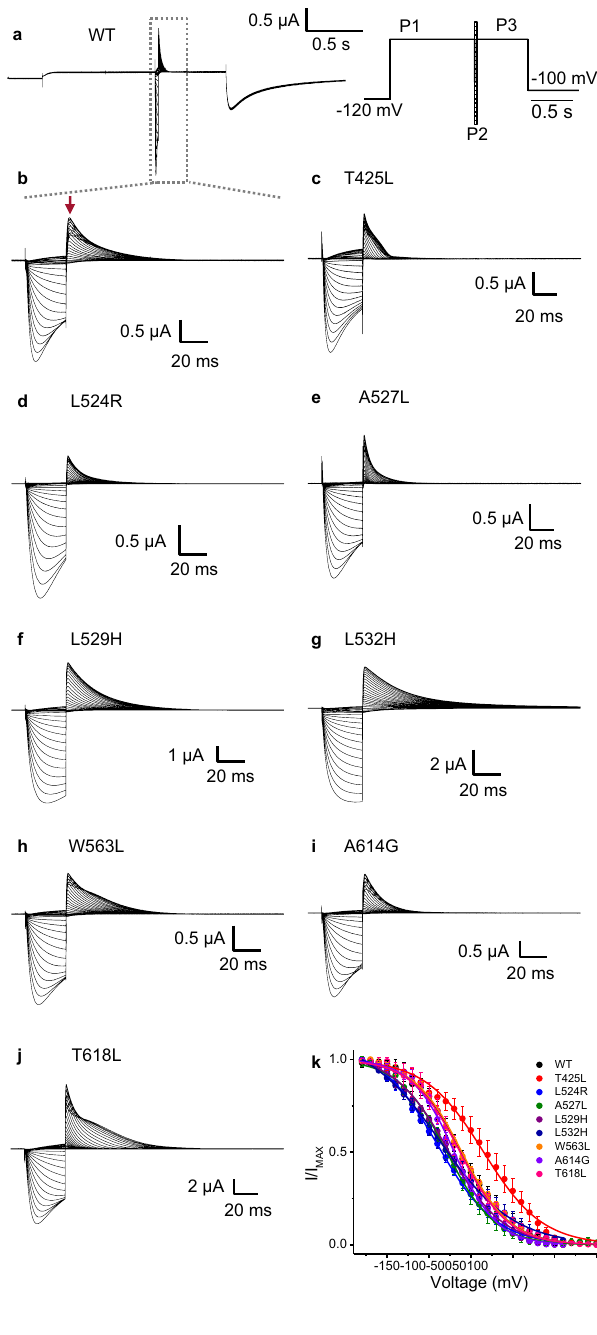
Fig. 4 | Voltage dependence of inactivation for mutations involved in the noncanonical path in hERG. a Currents elicited using a classical three-pulse vol- tageprotocolshowninsetina.Avoltagepulseto+20mV(P1)wasappliedfor1sto fully activate/inactivate the channel, followed by a voltage pulse (P2) applied to differentpotentialsfrom − 180to+60mVfor30ms.Thispulsewasusedtoremove inactivationwithoutallowingsuf fi cienttimeforsigni fi cantdeactivationtooccur.A fi nal pulse (P3) was then applied to +20mV for the reopening and allowed the channels to reenter into the inactivated state. For better appreciation of the cur- rentselicitedbypulses2and3,weexpandedthetimewindowofthecurrenttraces (dashed grey square in a ). b – j are, respectively, the representative expanded time window for WT, T425L, L524R, A527L, L529H, L532H, W563L, A614G, and T618L current traces. j Voltage dependence curve for inactivation. The voltage depen- denceofinactivationwasassessedbythepeakcurrentselicitedbyP3(redarrowin b and normalized by its maximum (I/I MAX ). For hyperpolarized potentials, < − 120mV, the channelsstart to deactivate whichreduces the currentelicitedbyP3, which underestimates the peak current. In order to account for this process, we corrected by extrapolating the currents back to the start of P2 from the falling phase of the currents elicited by P2 18 . For the right-shifted mutant T425L, for the mutantA527LP1andP3weresetto+80mVtoaccountfortheshiftintheG-Vcurve andtofullyinactivatethechannel.Similarly,forT618Lmutant,P1andP3weresetto +100mV to fully inactivate the channel. k Voltage dependence data for mutants. Thevoltagedependencedatawere fi ttedusingEq.7andthebest- fi ttedvalueswere displayed in Table 1. Data are presented as mean±SD (WT ( n =4), T425L ( n =6), L524R ( n =4), A527L ( n =5), L529H ( n =3), L532H ( n =5), W563L ( n =3), A614G ( n =5), and T618L( n =4), where n isthe number ofbiologicallyindependent